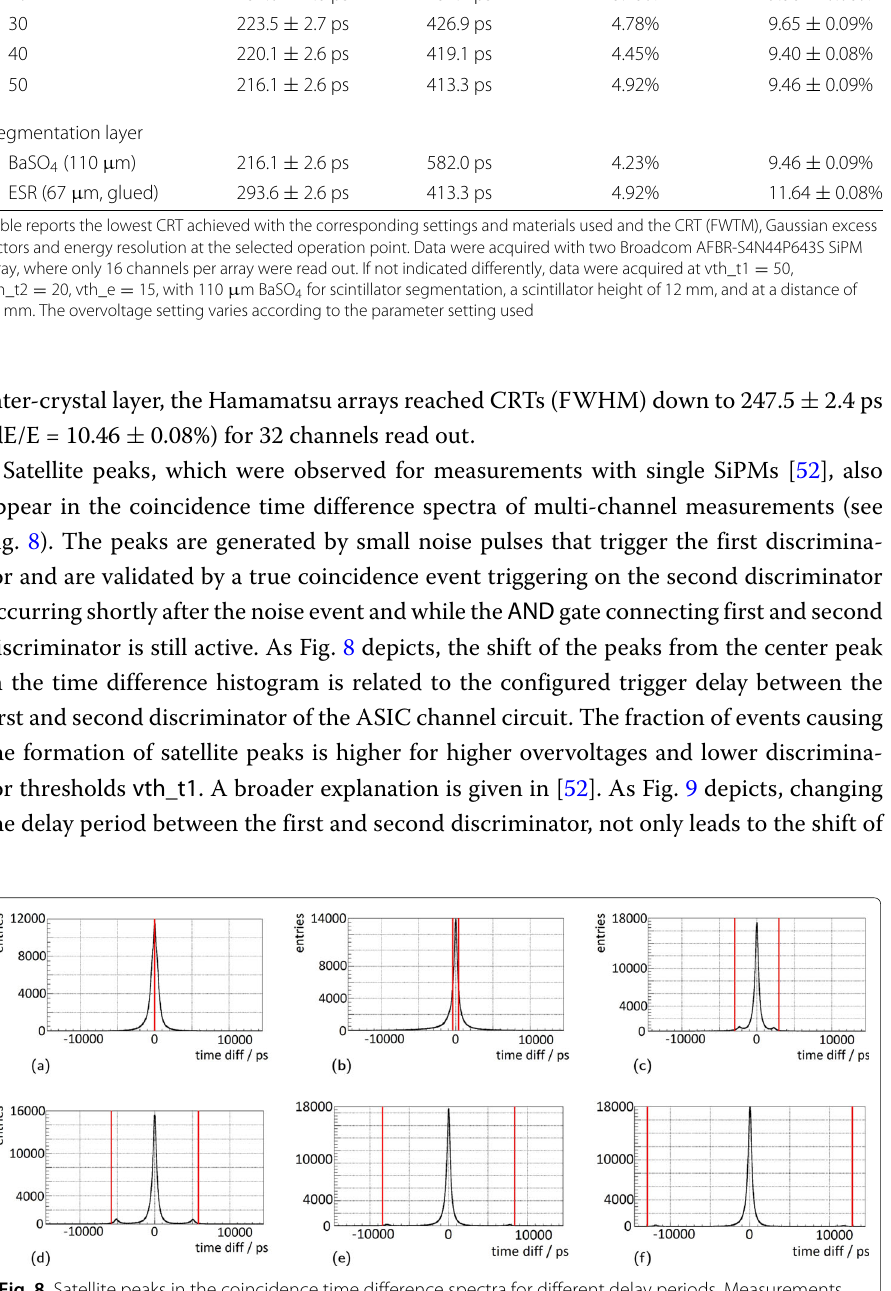
Fig. 8 Satellite peaks in the coincidence time difference spectra for different delay periods. Measurements were conducted with two KETEK PA3325-WB-0808 each coupled to an 8 × 8 12-mm-high LYSO scintillator array featuring 360 μ m BaSO 4 powder mixed with epoxy as segmentation layer. Data are collected at 4.75 V overvoltage and with vth_t1 = 10. A geometry of five NEMA cubes ( 22 Na sources) with a total activity of approximately 3 MBq is employed. Red lines indicate the configured delay period [49, 62]. a Delay line bypassed. b 0.39 ns. c 2.95 ns. d 5.8 ns. e 8.4 ns. f 12.9